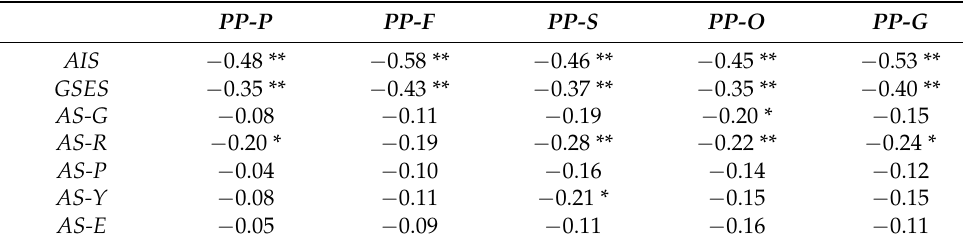
Table 3. Between-variable correlations—the UE subgroup. PP-P PP-F PP-S PP-O PP-G AIS − 0.48 ** − 0.58 ** − 0.46 ** − 0.45 ** − 0.53 ** GSES − 0.35 ** − 0.43 ** − 0.37 ** − 0.35 ** − 0.40 ** AS-G − 0.08 − 0.11 − 0.19 − 0.20 * − 0.15 AS-R − 0.20 * − 0.19 − 0.28 ** − 0.22 ** − 0.24 * AS-P − 0.04 − 0.10 − 0.16 − 0.14 − 0.12 AS-Y − 0.08 − 0.11 − 0.21 * − 0.15 − 0.15 AS-E − 0.05 − 0.09 − 0.11 − 0.16 −